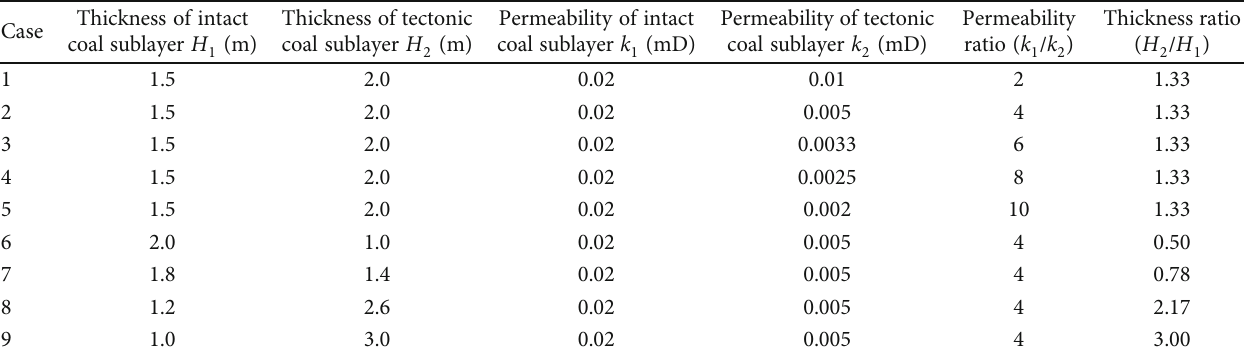
Table 2: Numerical simulation